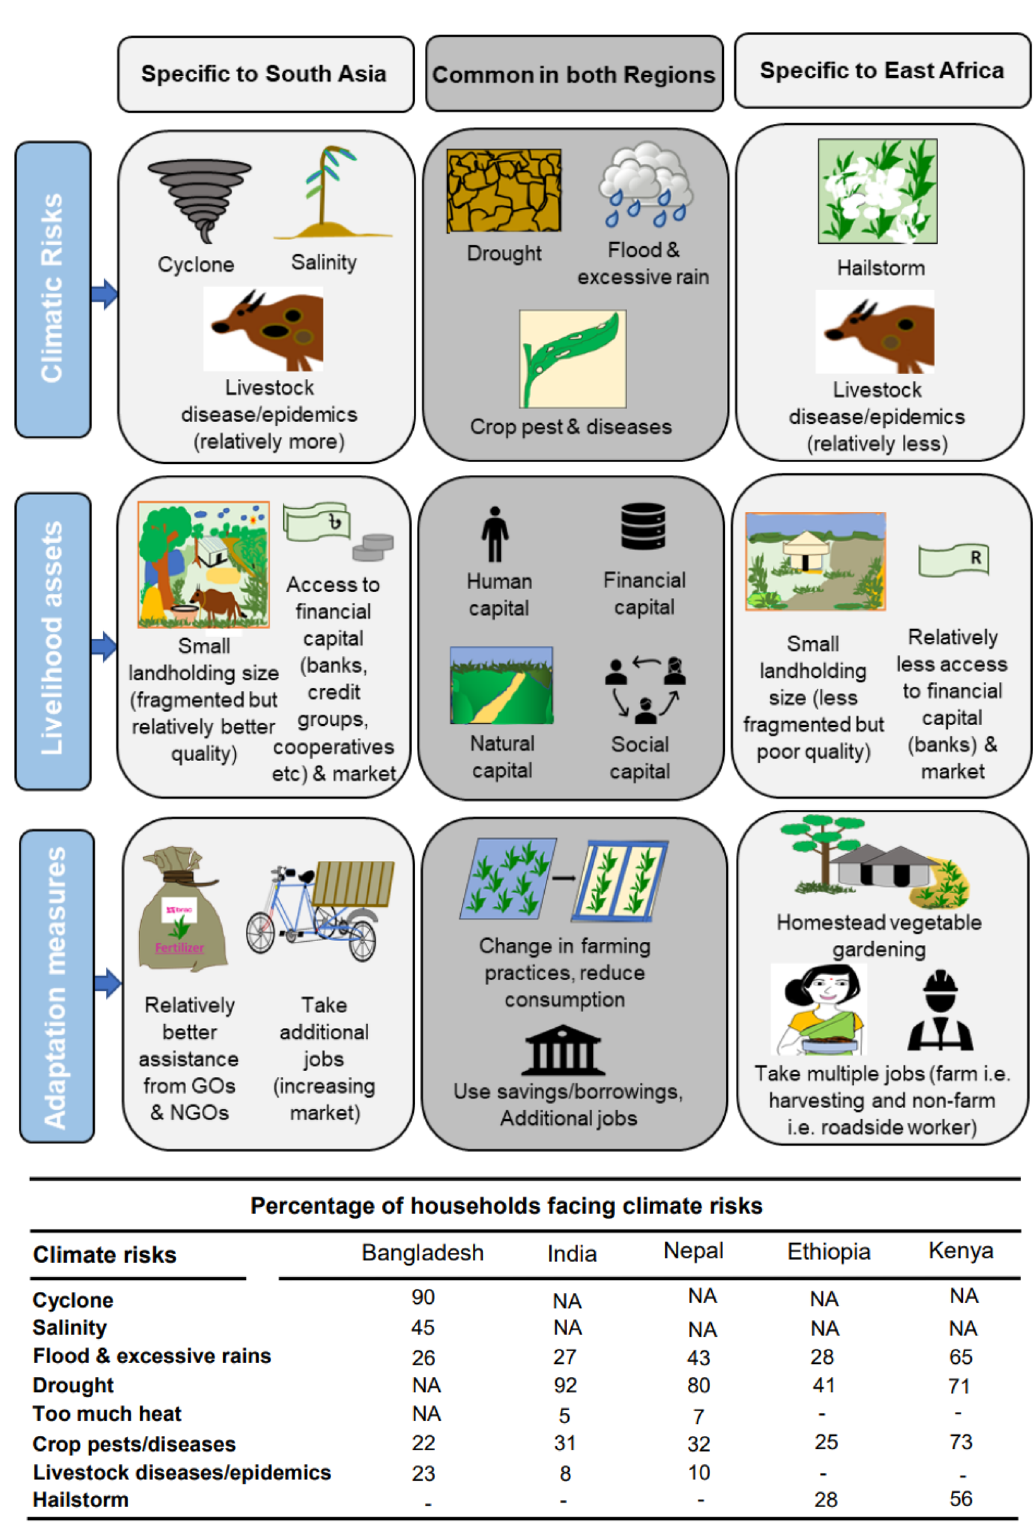
Figure 1. Major climate risks and adaptation strategies. Source: Prepared by the authors using Flowchart Maker and Online Diagram Software (https:// app. diagr ams.